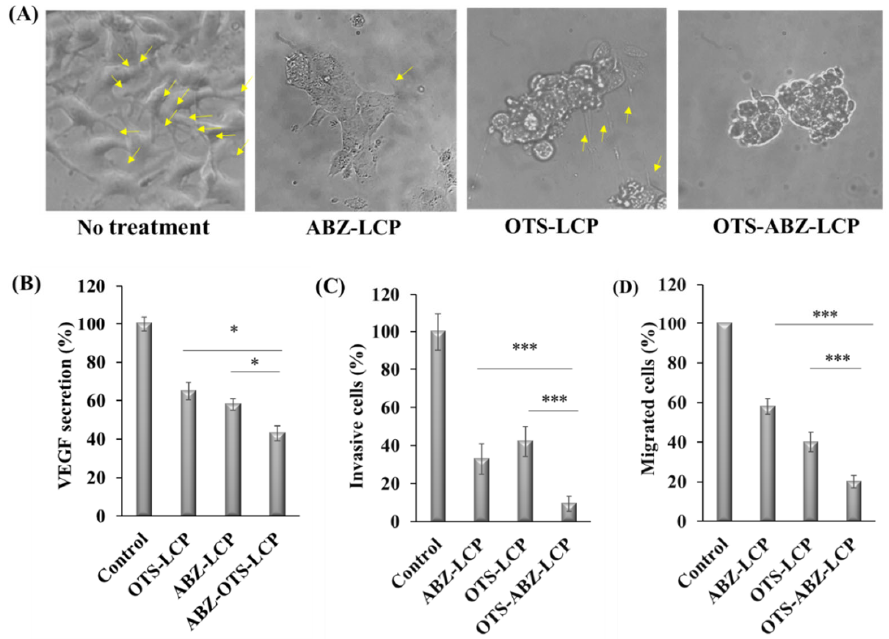
Figure 4. Effects of LCP-based formulations on biological behaviours of B16F0 cells . ( A ) Cell morphology changes after 4 h treatment; yellow arrows indicate the microtubules. ( B ) VEGF expression determined by ELISA kit; ( C ) invasive capacity of B16F0 cells treated with LCP formulations for 24 h determined by Transwell assay; and ( D ) relative migrated cells determined by wound healing assay for B16F0 cells treated with LCP formulations for 4 h. The equivalent concentrations of ABZ and OTS were 2.5 μ g/mL and 64 ng/mL, respectively. Data are presented as mean ± SEM (n = 3–5).